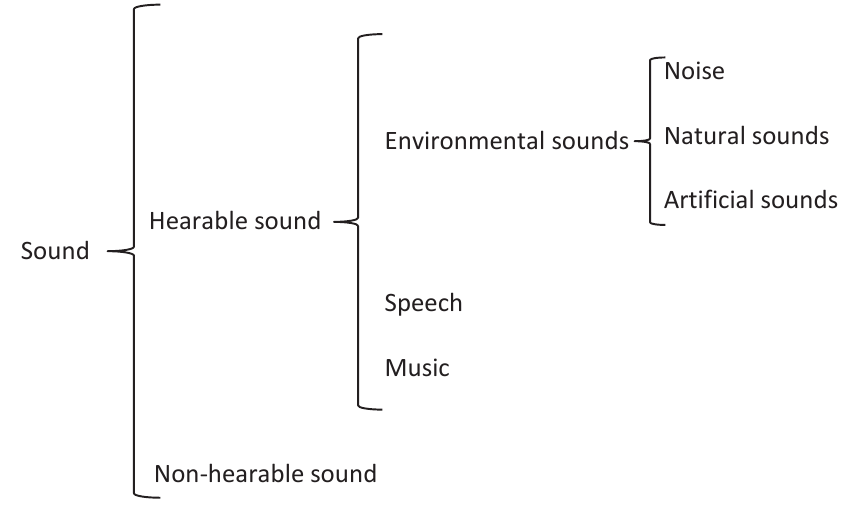
Figure 1. General sound classification scheme (adapted from